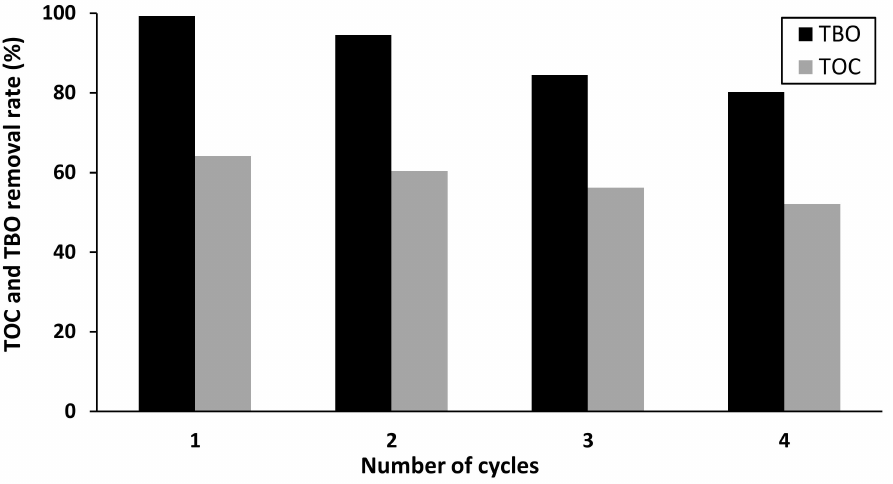
Figure 11. AC-Fe reusability for TBO removal from water. Experimental conditions: pH =